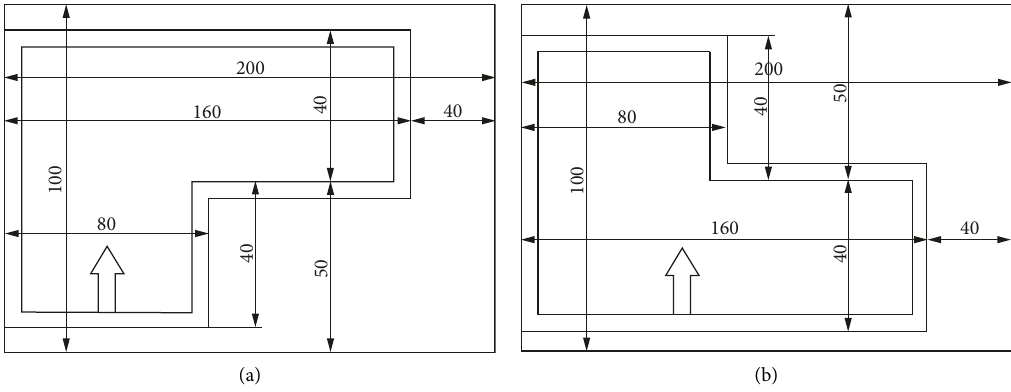
Figure 2: Plane model diagram of working face with variable length (unit: cm). (a) Forward knife handle working face. (b) Reverse knife handle working